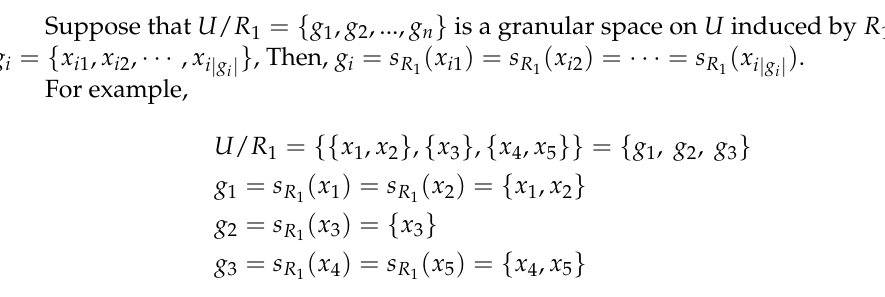
Figure 1. The relationship between md and